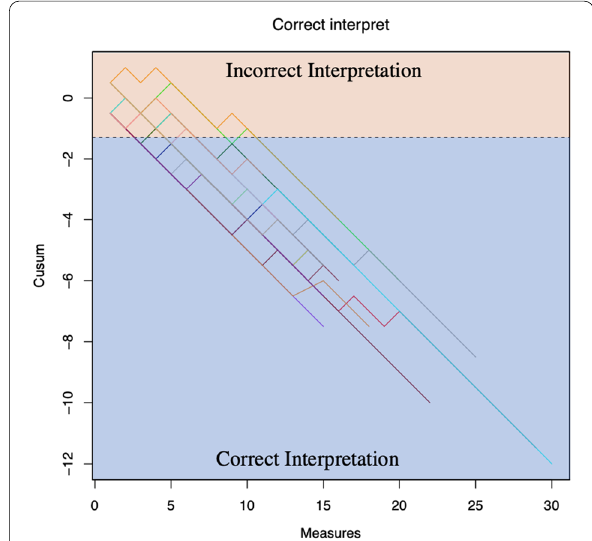
Fig. 2 Cusum plot for number of scans required to reach a correct overall interpretation